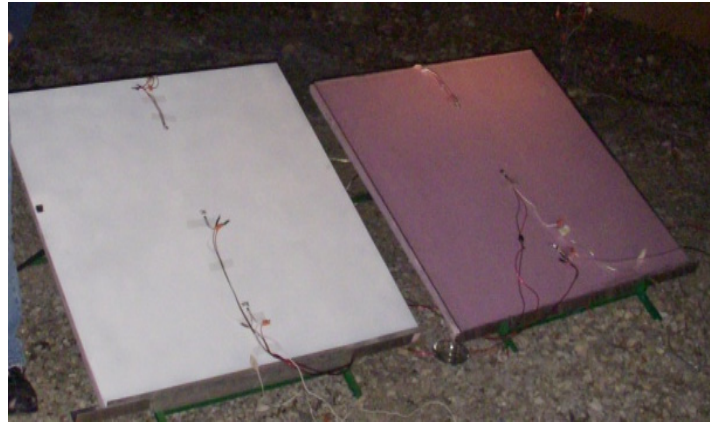
Figure 3. View of the white-painted aluminum and glass dew collectors.